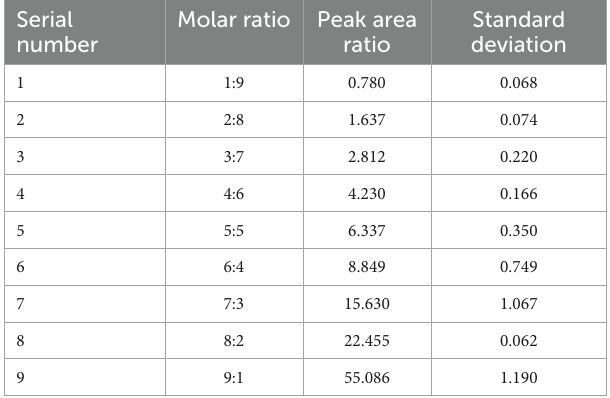
TABLE 1 Molar ratio of methane to nitrogen and the corresponding peak area